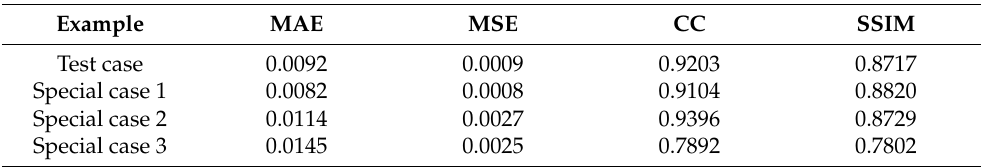
Table 2. Comparison of MAE, MSE, CC and SSIM for the example in Figure 6 from the test dataset and for all three given examples shown in Figures